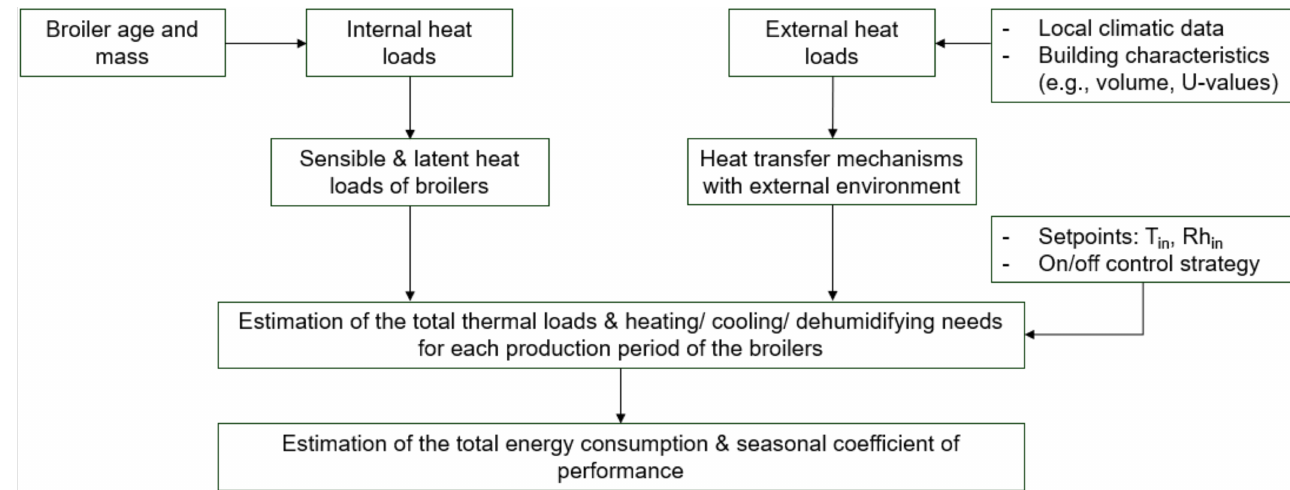
Figure 1. Flow diagram of the numerical model.